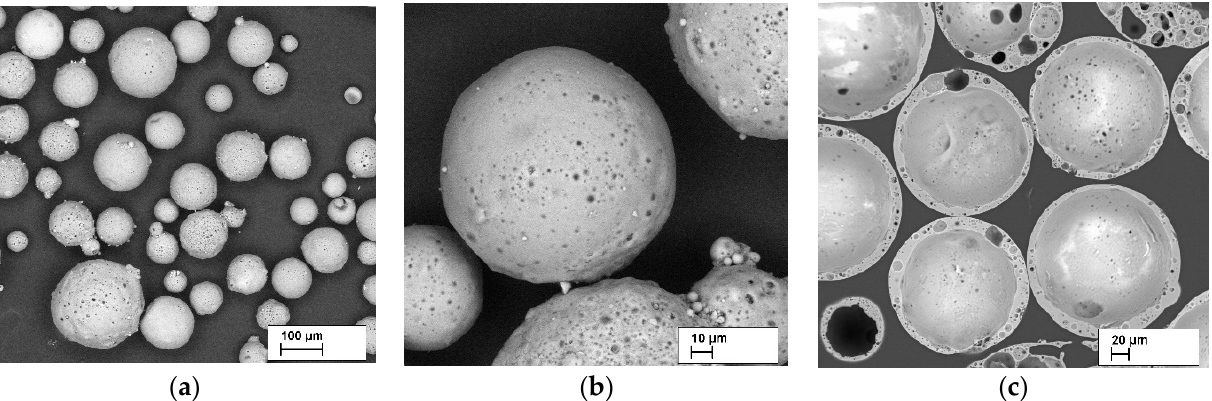
Figure 4. Scanning-electron-microscopy images of CS typical appearance at × 100 times magnification ( a ), at × 500 ( b ) and cross-section × 200 times magnification ( c